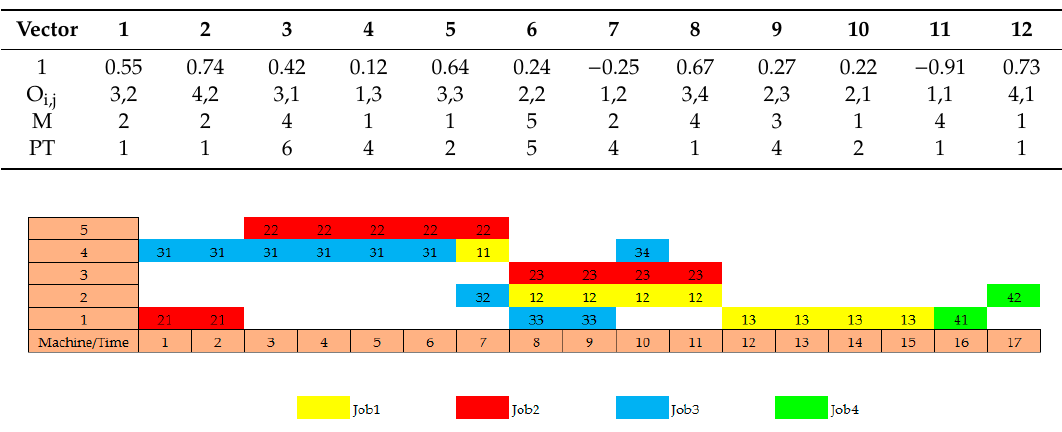
Figure 4. Gantt chart of sample problems.